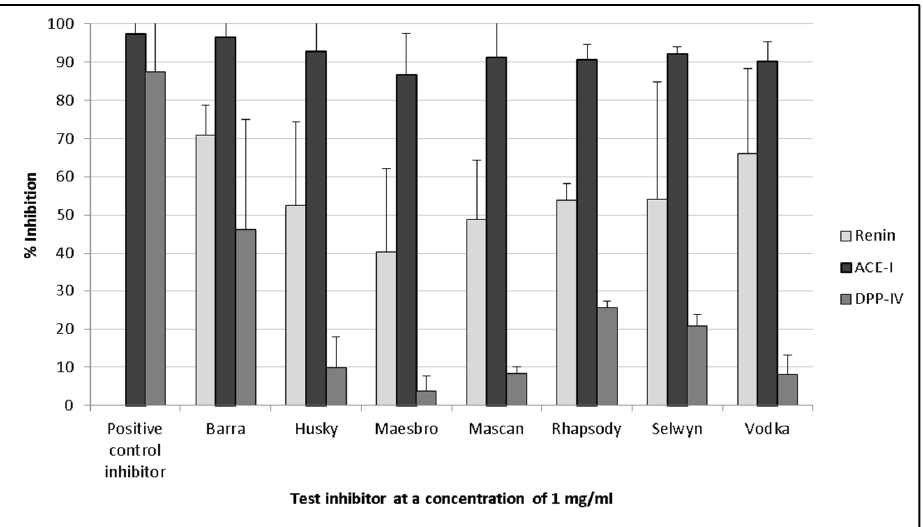
Figure 2. Inhibition bioactivity for the targets renin, angiotensin ‐ I ‐ converting enzyme (ACE ‐ I),